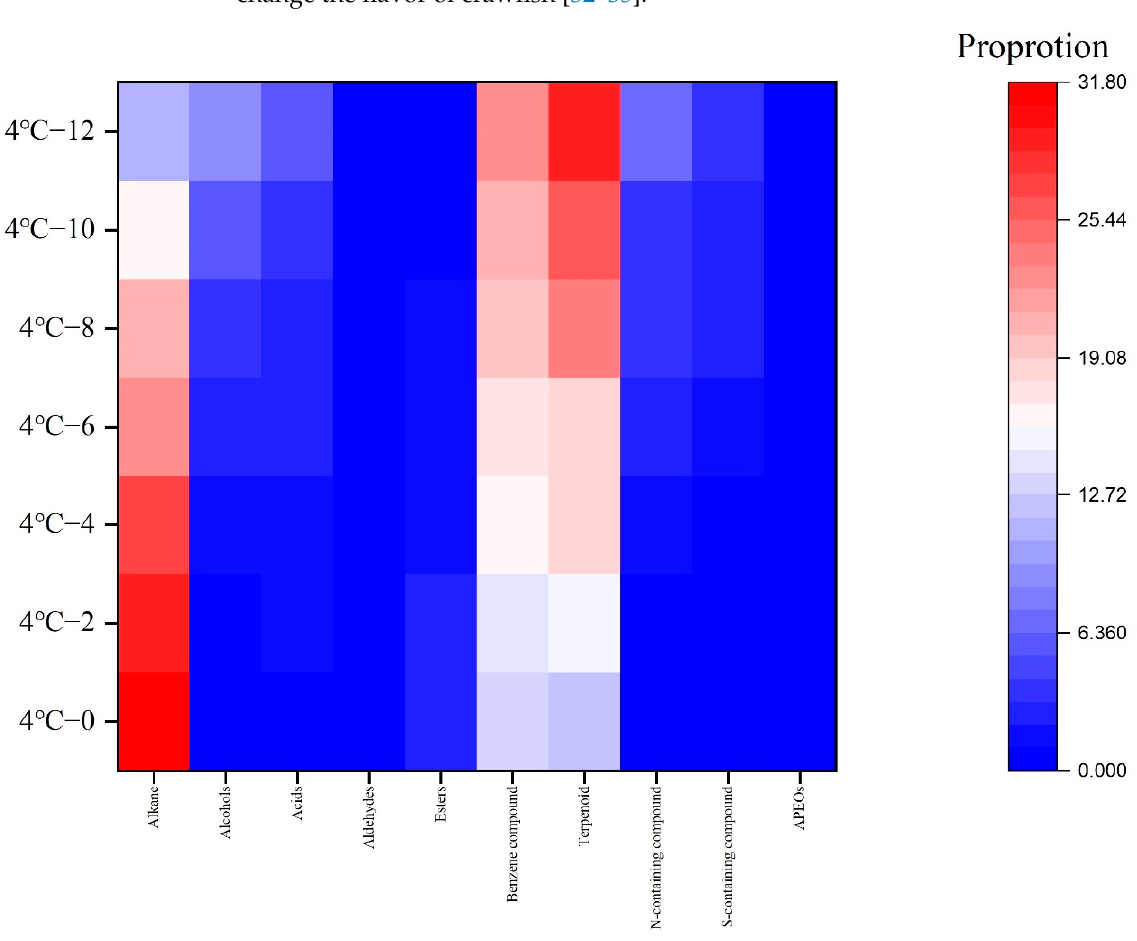
Figure 3. The volatile flavor compounds of crawfish at 4 °C in vacuum packaging.